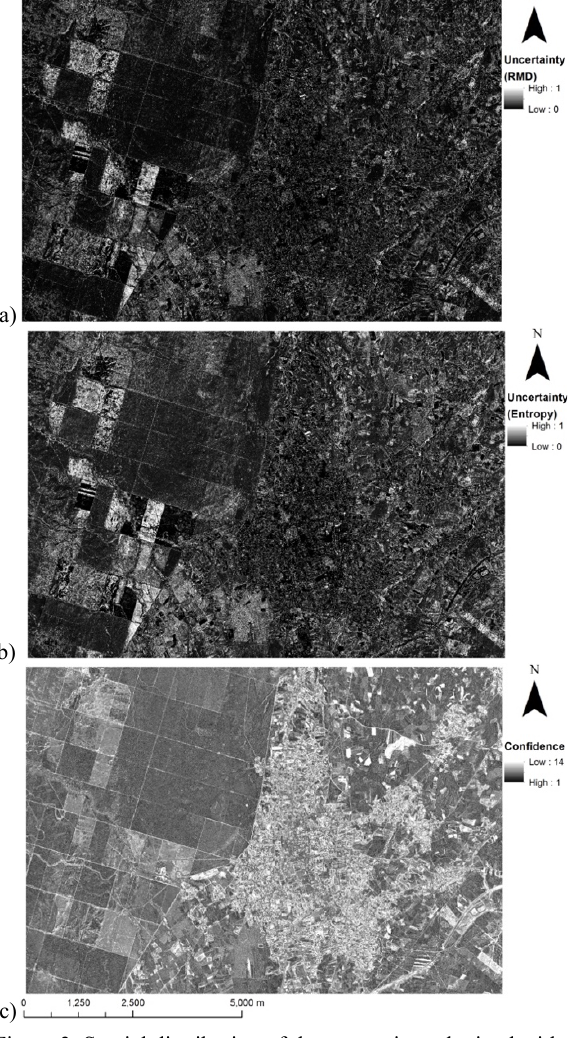
Figure 3. Spatial distribution of the uncertainty obtained with: Figure 4. Regions with high, medium and low uncertainty a) RMD, b) normalized entropy and c) classification obtained with a) the RMD uncertainty measure, b) the confidence normalized entropy. Regions with high, medium and low confidence are shown in